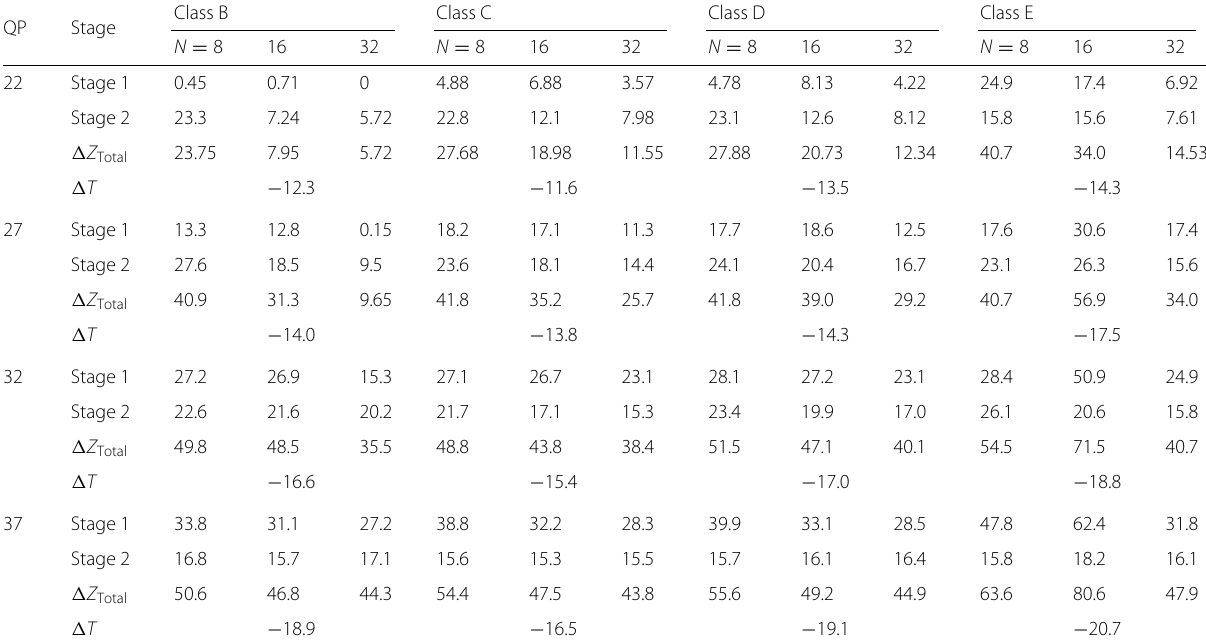
Table 2 Resulting (cid:7) Z (%) and (cid:7) T (%) values for the tested image sequences using the proposed two-stage method QP